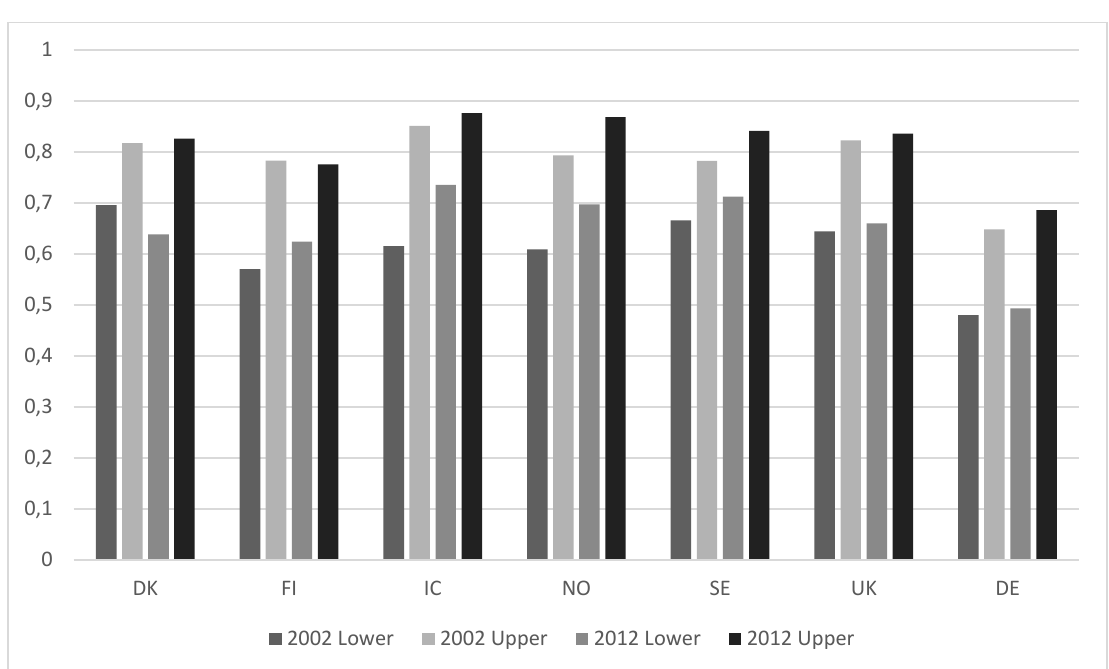
Figure 6: Good and very good self-assessed health in lower and upper half of income groups in the Nordic countries, UK and Germany, 2002 and 2012